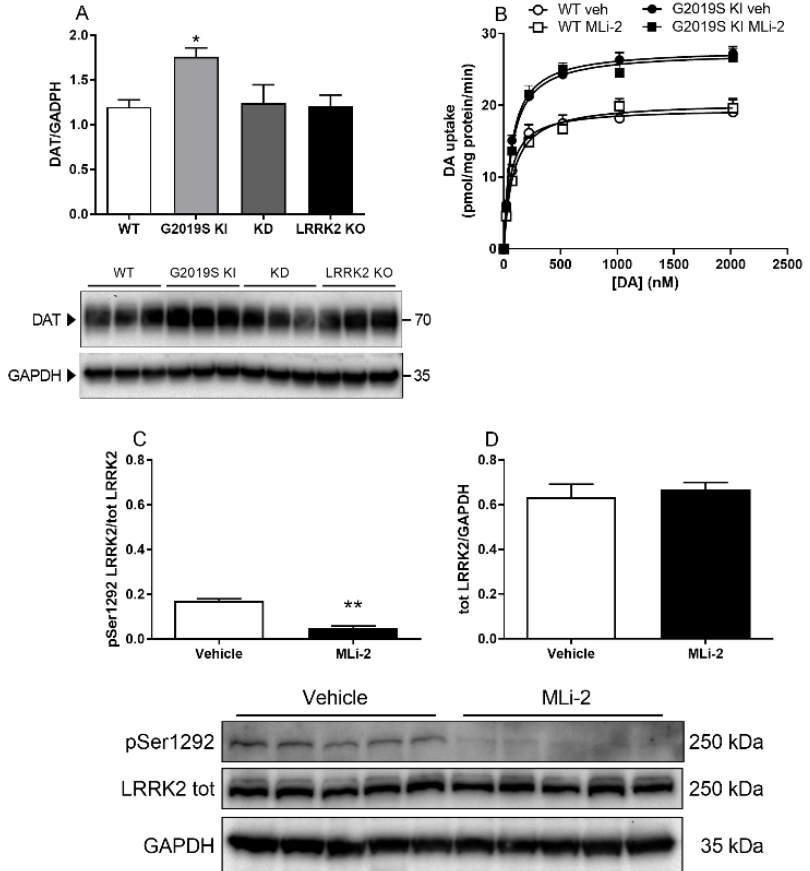
Figure 3. The increase of DAT levels is associated with the G2019S mutation but not sustained by ongoing LRRK2 kinase activity. ( A ) Western blot analysis of DAT levels in the striatum of 12-month- old G2019S KI, LRRK2 KO and KD mice in comparison with WT controls, and representative blots. Data are means ± SEM of n = 6 mice per group * p < 0.05 different from WT (one-way ANOVA followed by the Tukey test). ( B ) Kinetic analysis of [ 3 H]-DA uptake in striatal synaptosomes of 12-month-old G2019S KI and WT mice acutely treated with MLi-2 (10 mg/Kg i.p.) or vehicle. Data are expressed as mean ± SEM of n = 4 mice per group. ( C – D ) Western blot analysis of pSer1292 LRRK2 and total LRRK2 levels in the striatum of G2019S KI mice administered with MLi-2 (10 mg/Kg, i.p.) or vehicle, and representative blots. Data are expressed as mean ± SEM of n = 5 mice per group. ** p < 0.01 different from Vehicle (Student t -test two-tailed, for unpaired data).